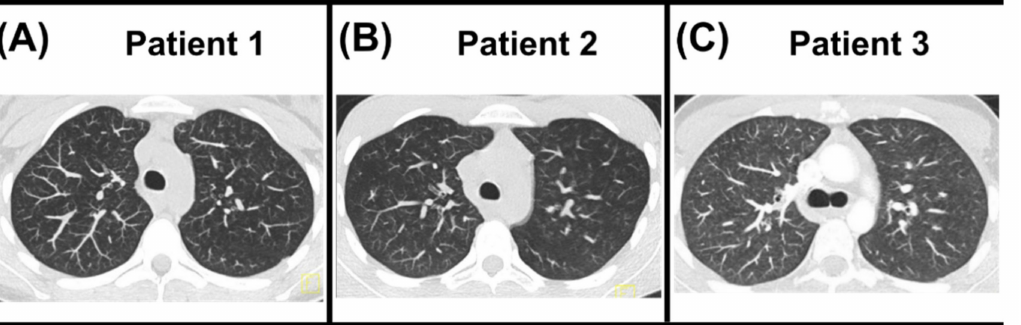
Figure 3. CT follow-up. ( A ) Follow-up CT of Patient 1 after 6 months showed near complete resolution of the previously extensive tree-in-bud pattern. ( B ) Follow-up CT of Patient 2 after 35 months showed no tree-in-bud pattern but centrilobular nodular hazy densities with upper lobe predominance suspicious for respiratory bronchiolitis disease, possibly secondary to inhaled